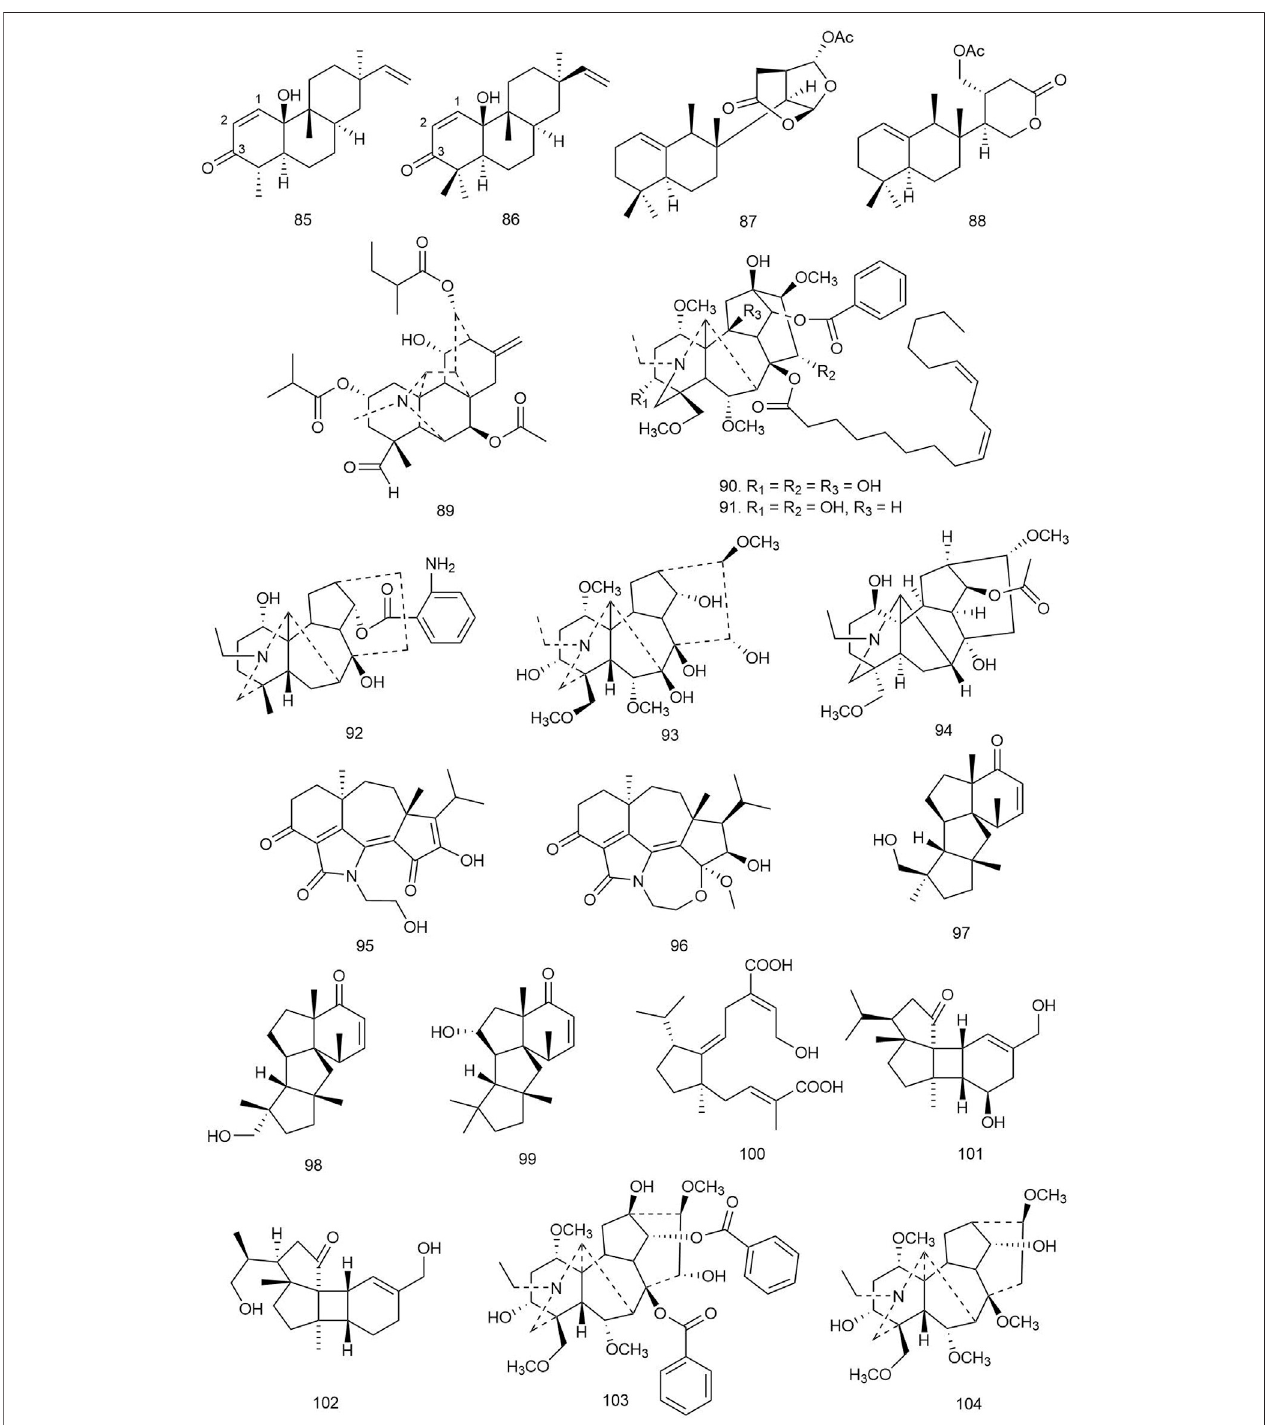
FIGURE 6 | Structures of rosane, spongian, vakognavine, and miscellaneous diterpenoids with signi fi cant antibacterial activity.